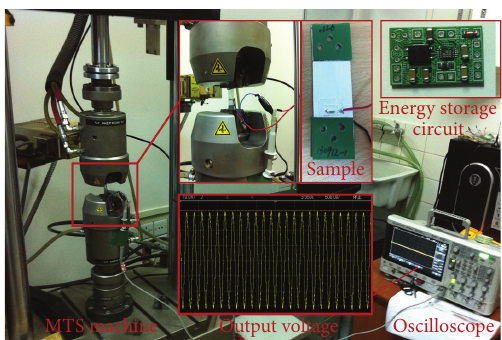
Figure 10: Testing system.